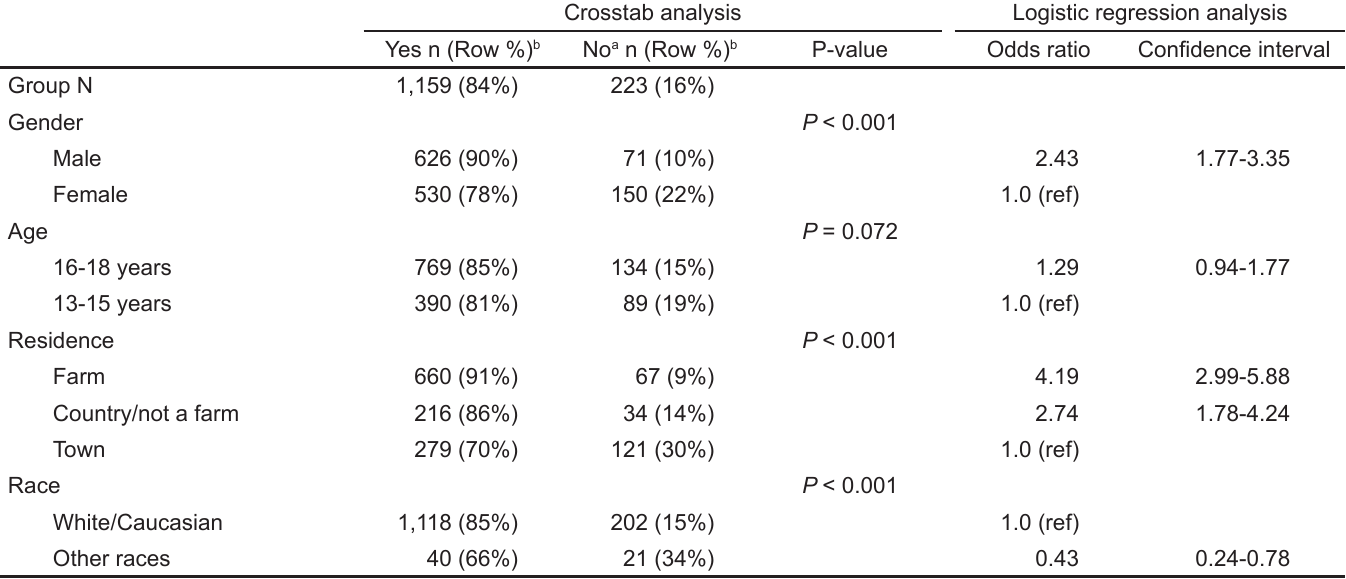
Table 2. Bivariate and multivariate logistic regression analyses regarding the presence of rifles/shotguns in the homes of adolescent survey respondents.